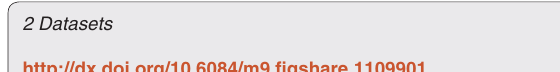
figshare: Data of M-laurdan characterization to explore order in lipid membranes, doi: http://dx.doi.org/10.6084/m9.figshare.1109901